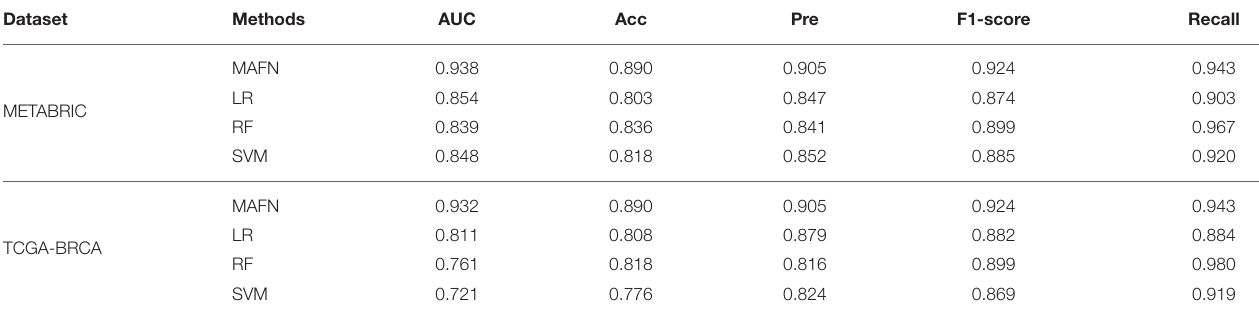
TABLE 5 | AUC, Acc, Pre, F1-score, and Recall predictive performance metrics of MAFN and existing non-deep learning-based methods.